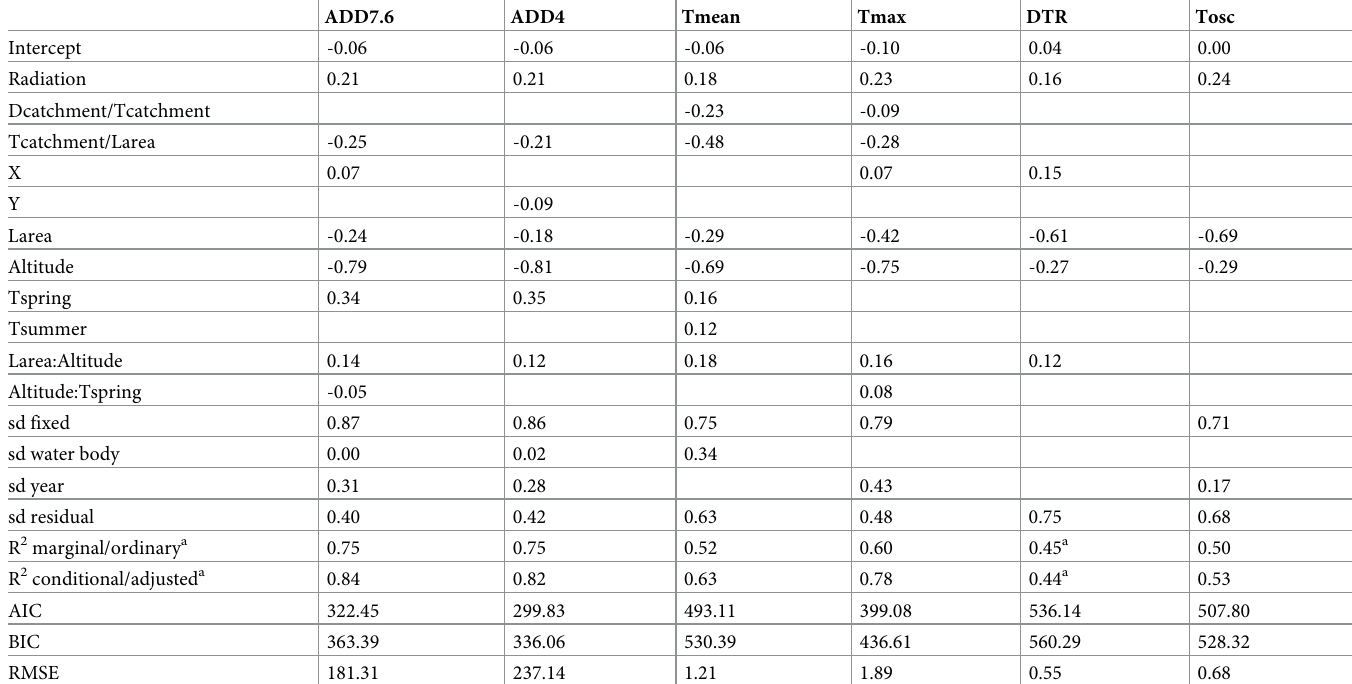
Table 1. Summary of the coefficients of the mixed